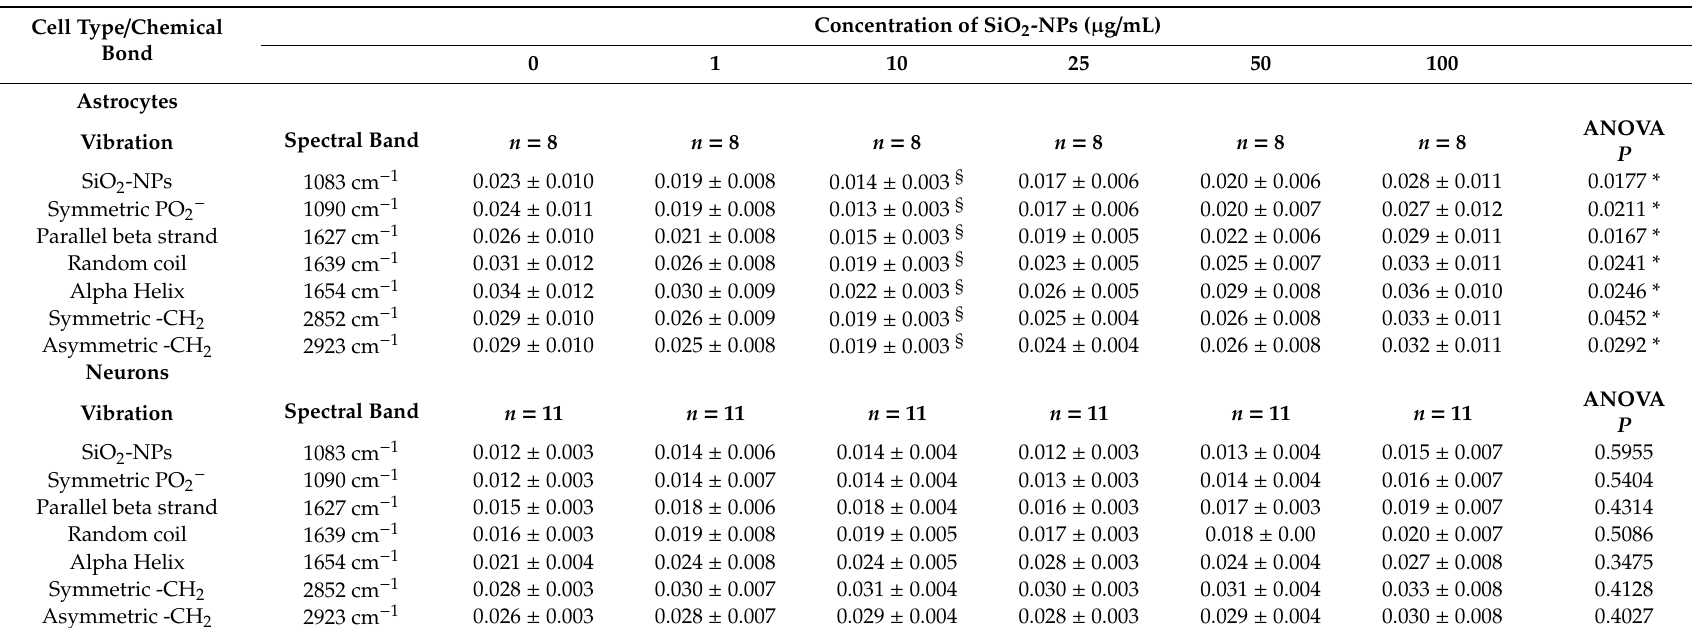
Table 1. Second derivative analysis of spectral bands (cm − 1 ) of chemical bond for nucleic acids, protein and lipid regions of rat astrocytes and neurons exposed to